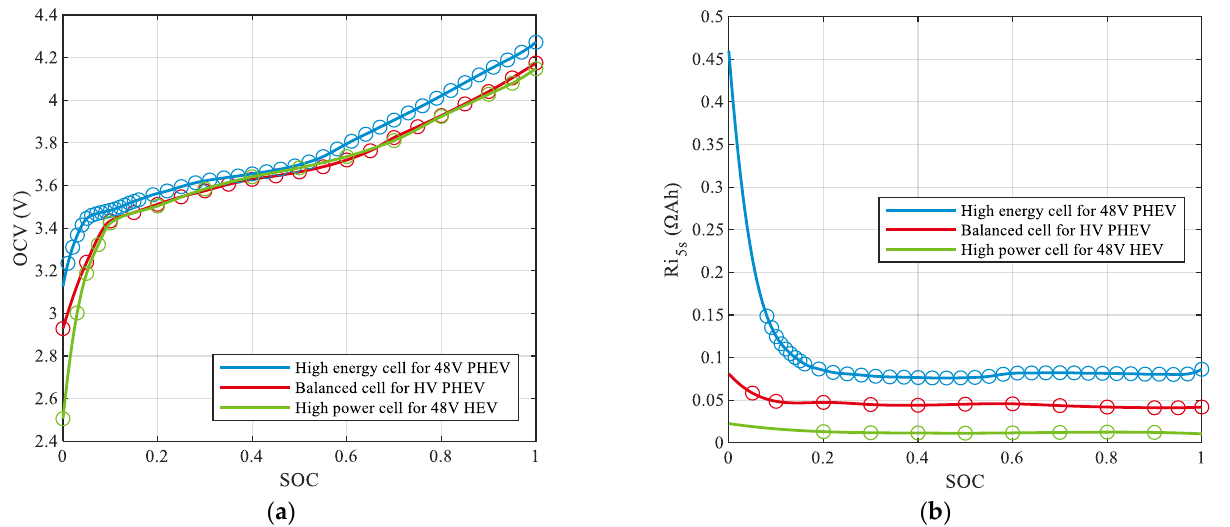
Figure 6. Measured ( a ) open-circuit voltage and ( b ) internal resistance curves for three different cell types.